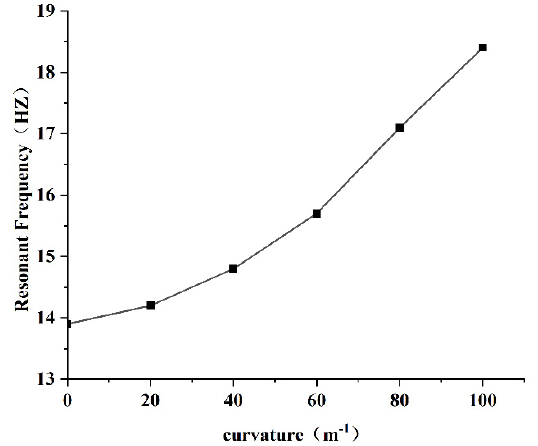
Figure 7. Schematic diagram of resonant frequency.